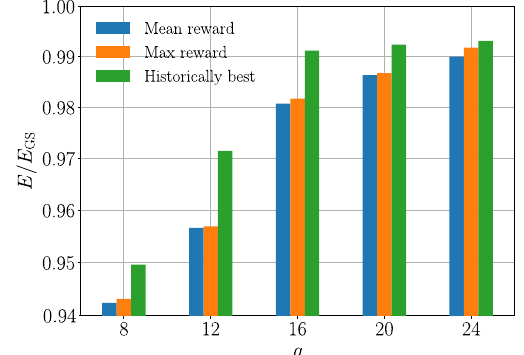
FIG. 12. Spin-1 Ising model: energy minimization against different circuit depths q using CD-QAOA. The mean negative energy density (blue) is computed for a sample generated using the final, learned policy; max (orange) is the maximum within the sample; the historically best (green) is the best encountered policy during the entire training process (i.e., considering all iterations). The total duration T ¼ 20 , and the values of q range from 8 to 24. The other model parameters are the same as in Fig.